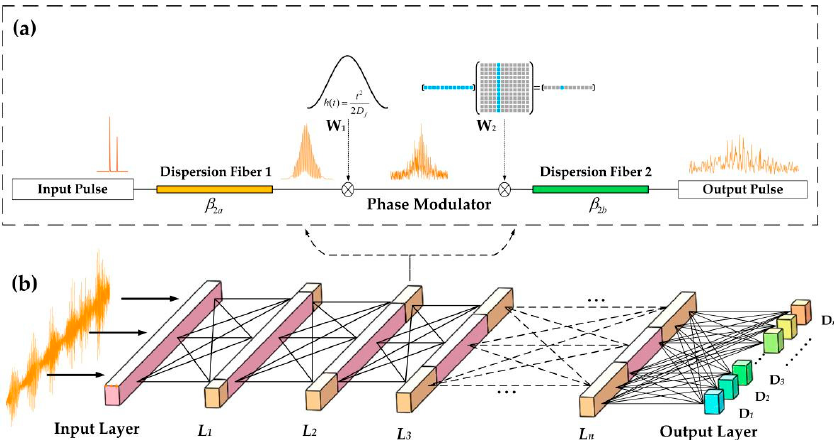
Figure 1. Optical neural network structure based on time-lens (TL-ONN). ( a ) The time-lens layer algorithm. The input data first pass through the first part of the dispersion fiber, undergoing phase modulation W 1 , W 2 after the dispersion Fourier transform; the modulator reaches the optimal solution of the network after deep learning, and finally passes through the second segment of the dispersion fiber to complete the data transmission of each time-lens layer. β 2 a , β 2 b —the group- velocity dispersion of fiber 1 and fiber 2, respectively. W 1 , W 2 —the phase modulations. ( b ) TL-ONN structure. It comprises multiple time-lens layers. All time points on one layer can be regarded as neurons, and the neurons are transmitted through dispersion. L 1 , L 2 , . . . , L n —layers. D 1 , D 2 , . . . , D n —detectors.